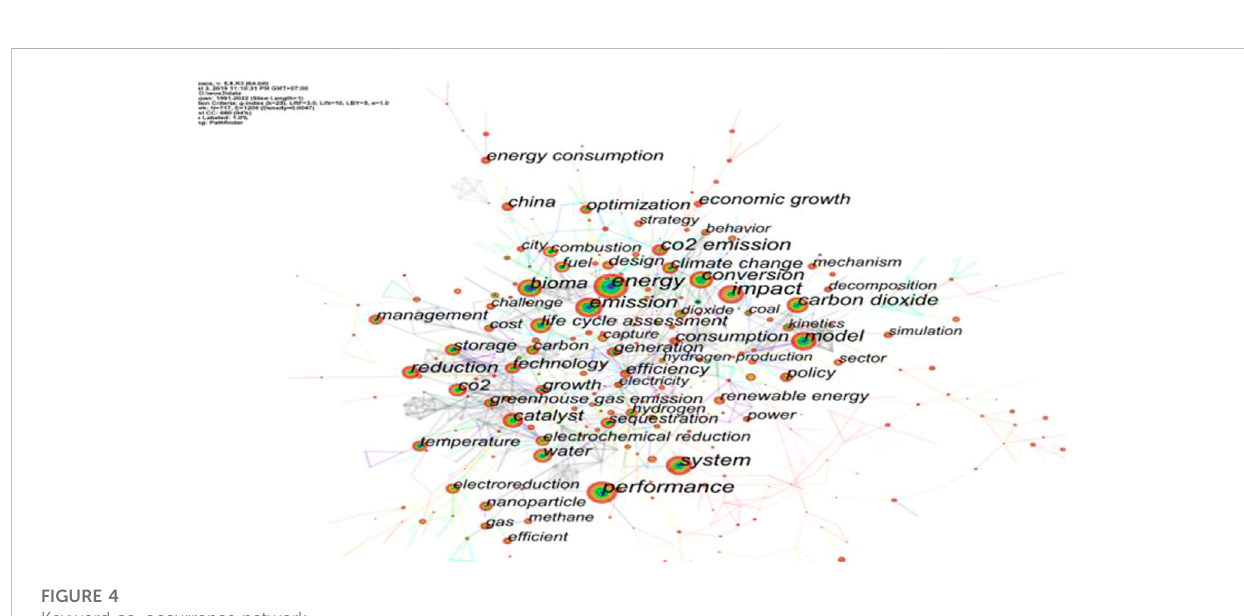
According to the results of the centrality analysis, the top ten keywords with the highest centrality were: CO 2 (0.52), bioma